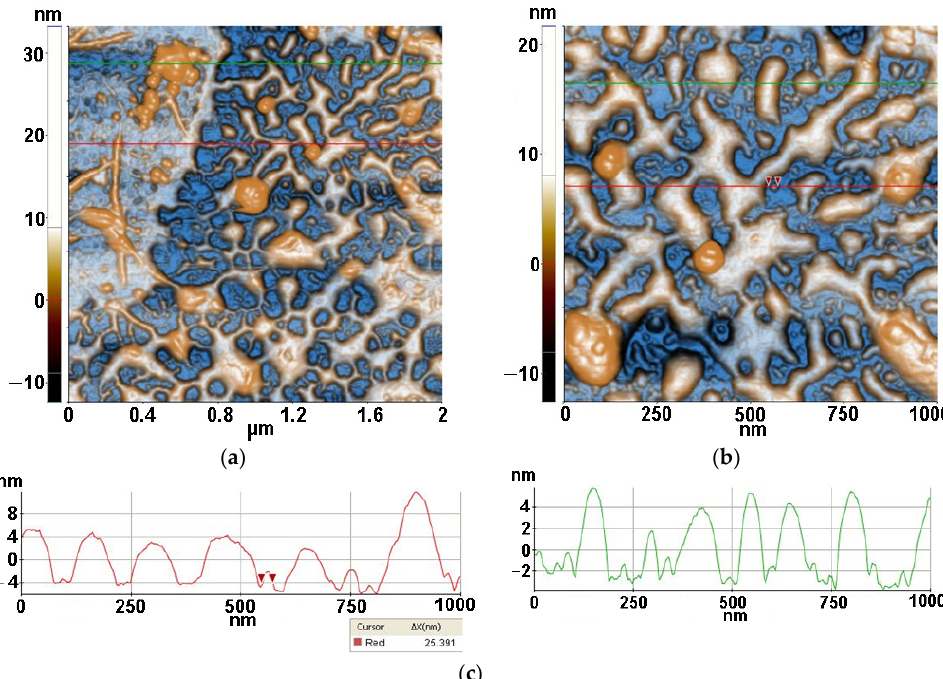
Figure 5. Two-dimensional AFM image for lysozyme deposited on TiO 2 /Si substrate, scanned at the scale of (2 μ m × 2 μ m) ( a ) and at the scale of (1 μ m × 1 μ m) ( b ), together with two horizontal characteristic surface profiles (line-scans) ( c ), plotted from ( b ).